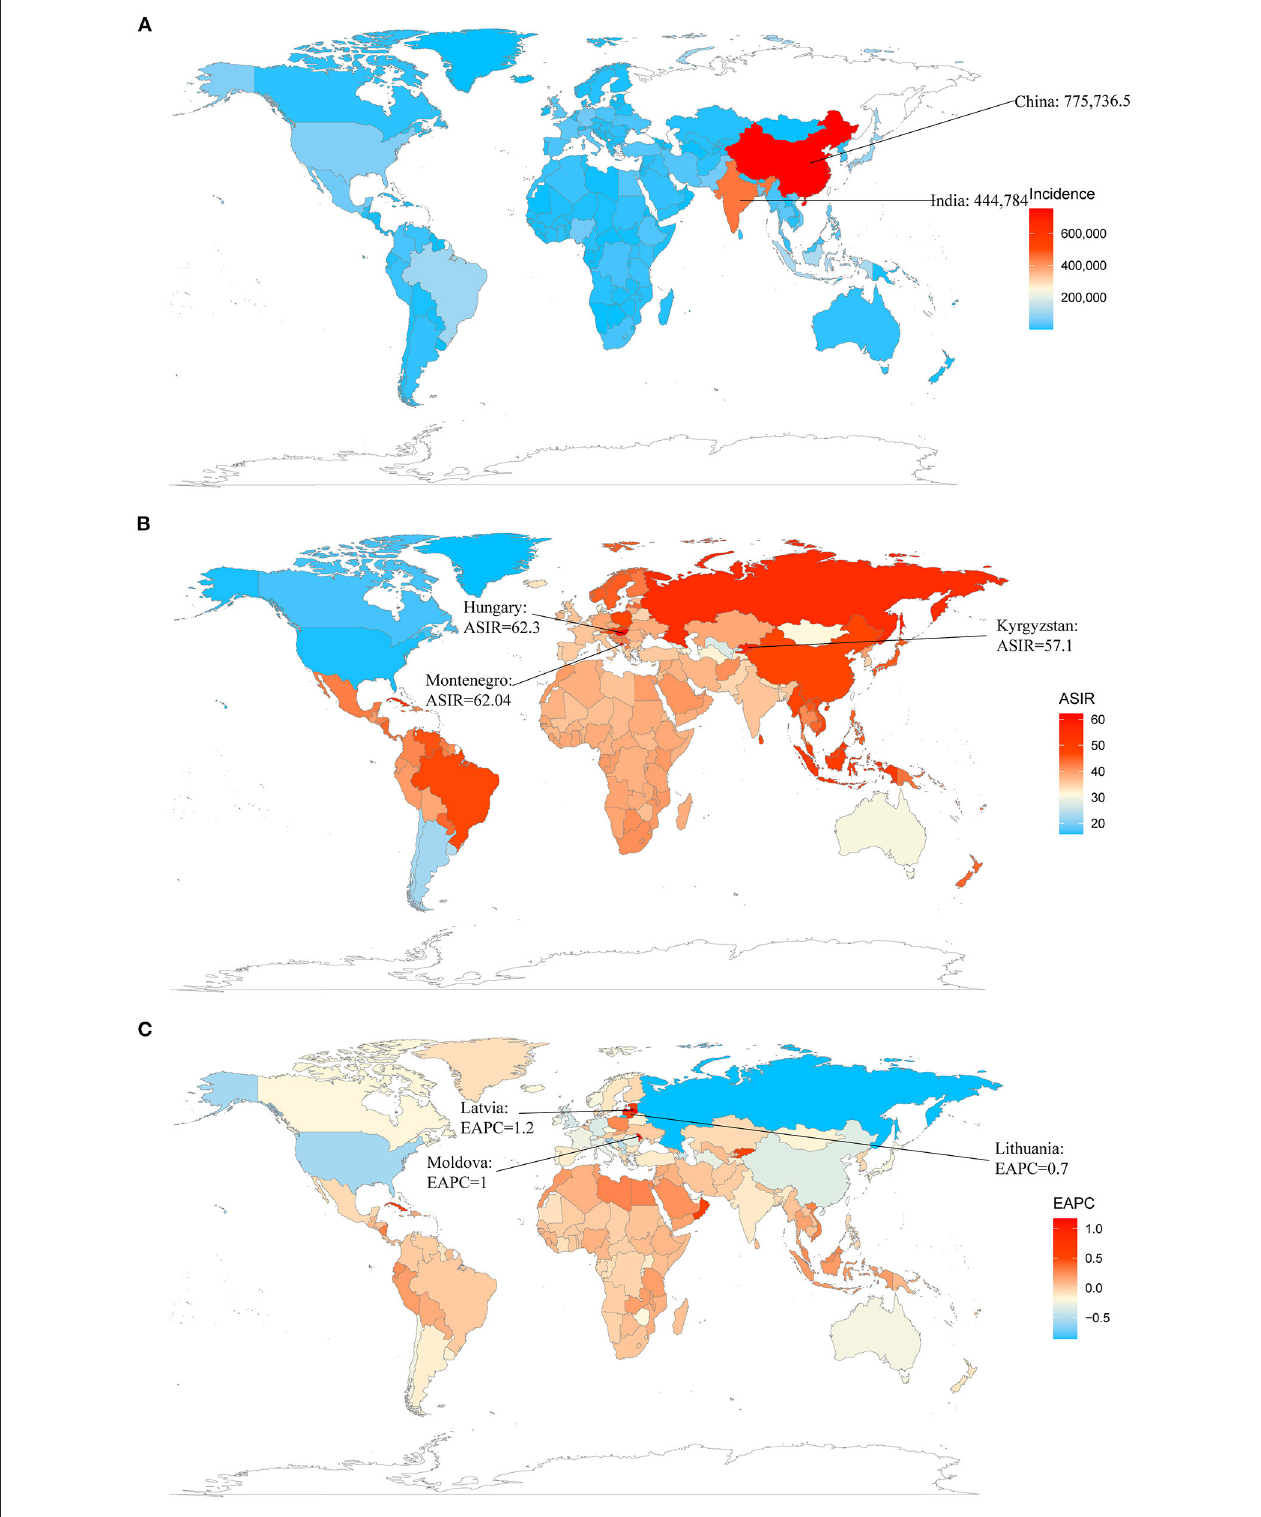
FIGURE 1 | The global incidence burden of myocarditis in 195 countries and territories. (A) The absolute number of myocarditis incidence cases in 2017. (B) The ASIR of myocarditis in 2017. (C) The EAPC of myocarditis ASIRs between 1990 and 2017. ASIR, age-standardized incidence rate; EAPC, estimated annual percentage